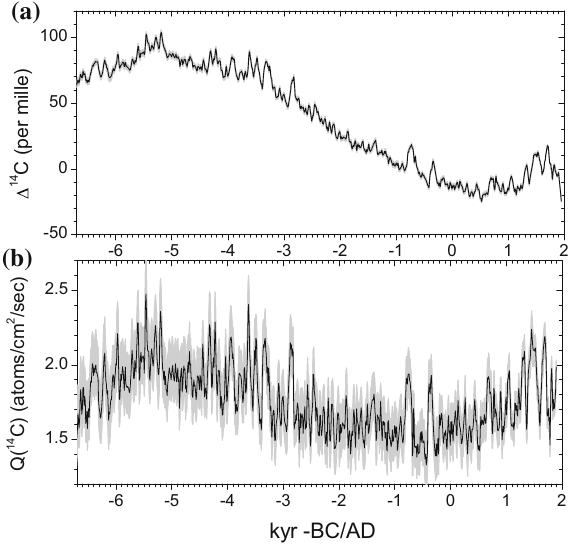
Fig. 8 Radiocarbon series for the Holocene. Upper panel Measured content of Δ 14 C in tree rings by IntCal13 collaboration (Reimer et al. 2013) (http://www.radiocarbon.org/IntCal13.htm). The long-term trend is caused by the geomagnetic field variations and the slow response of the oceans. Lower panel Production rate of 14 C in the atmosphere, reconstructed from the measured Δ 14 C, along with the 95% confidence interval (Roth and Joos